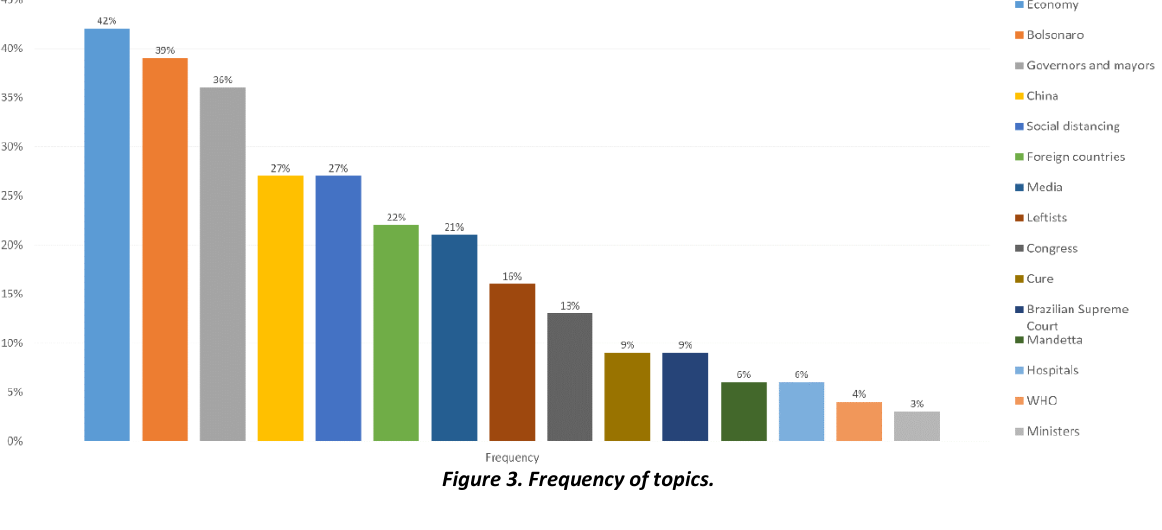
Figure 3. Frequency of topics.